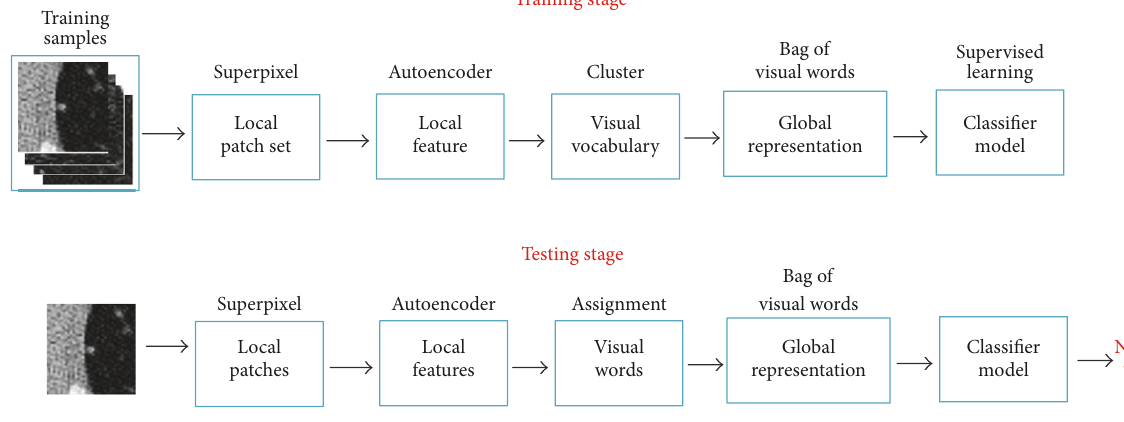
Figure 2: Framework of the proposed